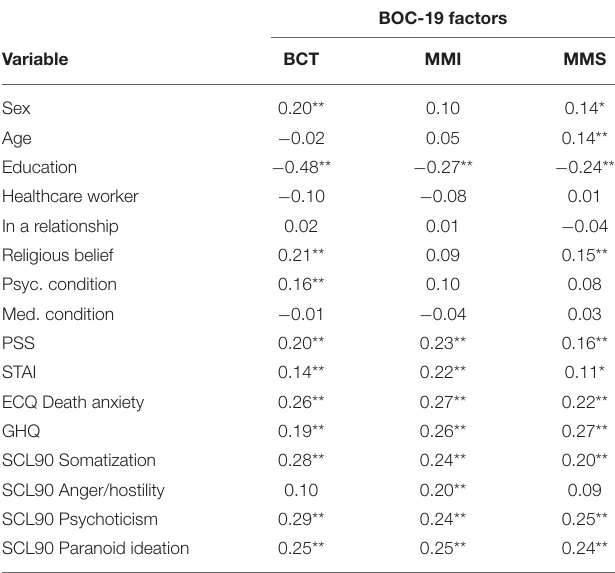
TABLE 3 | Correlation coefficients of BOC-19 factors with sociodemographic and psychological variables.